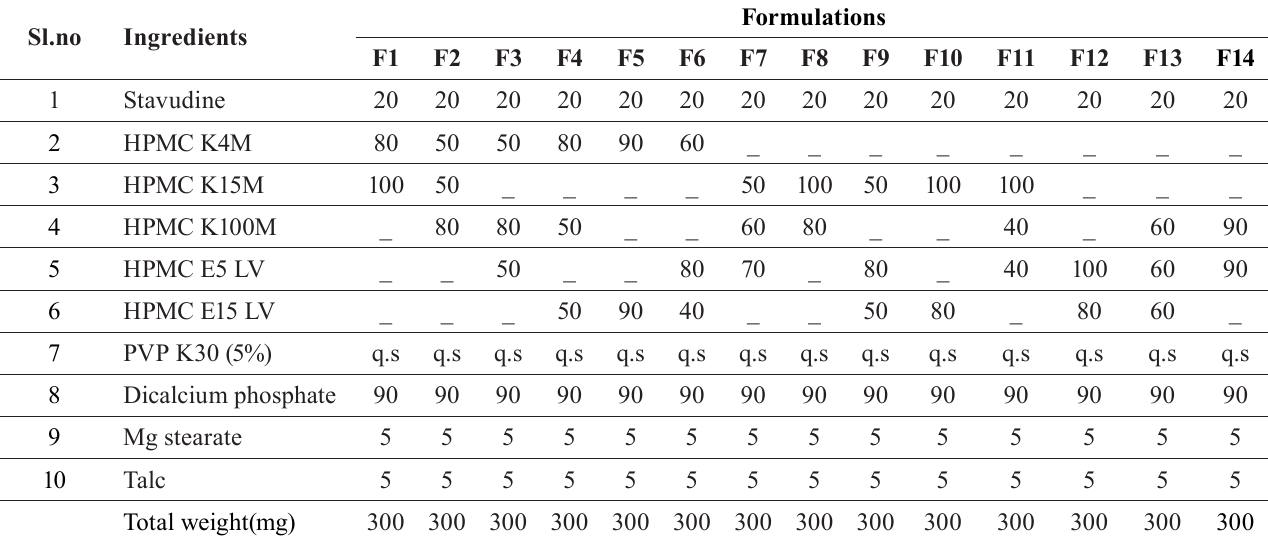
TABLE I - P reliminary trial batches for controlled release tablets